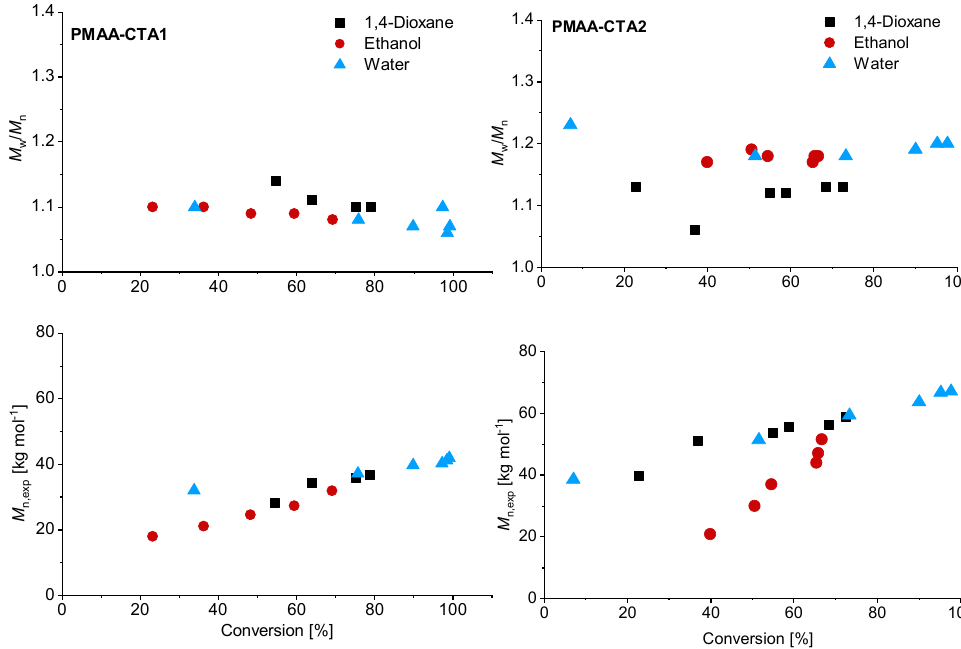
Figure 3. Reaction time versus conversion of the RAFT polymerization of PMAA with CTA1 ( left ) and CTA2 ( right ) with a [MAA]/[CTA] = 120 and [CTA]/[ACVA] = 10. The SEC results were measured in an aqueous set up with PEO standards.